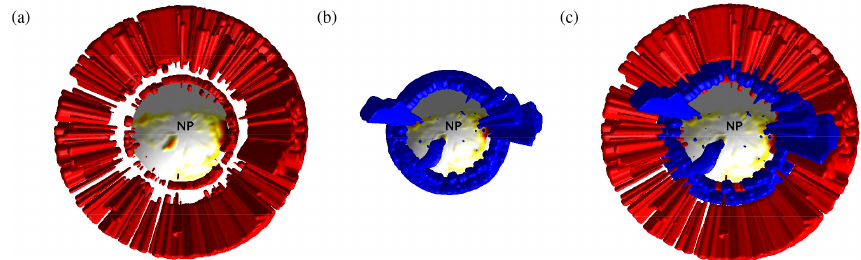
Figure 12. North Pole view of the Earth showing the isosurfaces 3.5pAm − 2 (red) and − 3 . 5pAm − 2 (blue) for the global solution of the GEC